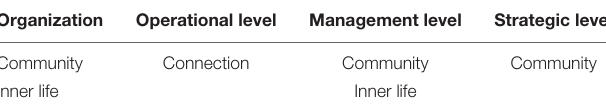
TABLE 6 | One-dimensional factors for the organization and its levels. TABLE 7 | Neutral factors for the organization and its